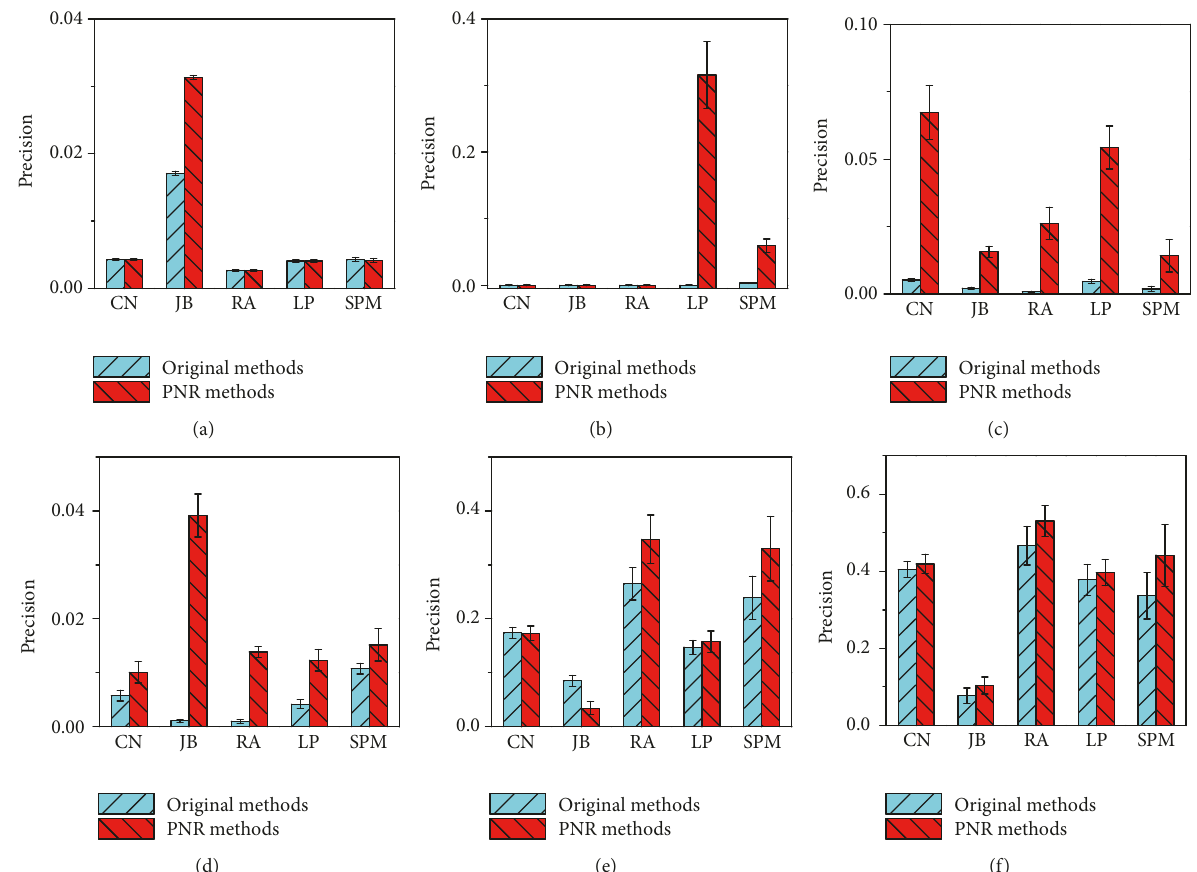
Figure 6: Precision comparison of the proposed methods (red) and traditional high similarity based methods (cyan) for six real-world networks. (a) Email network. (b) PDZBase network. (c) Euroad network. (d) Neural network. (e) Roundworm network. (f) USair network. Results are the average of 50 independent simulations. Our proposed framework increases precision in most